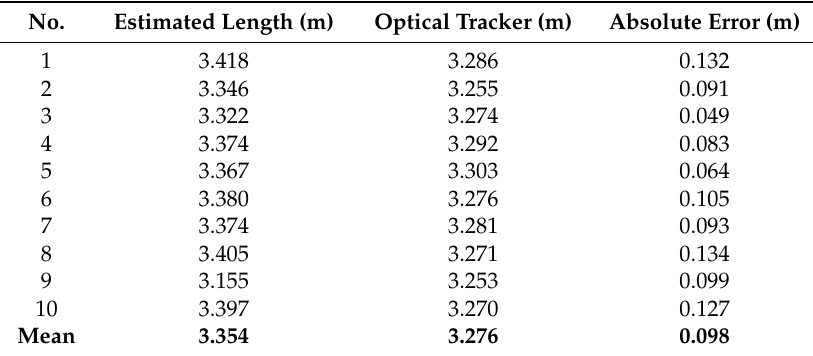
Table 1. Quadripod cane’s estimated and reference walking distance.